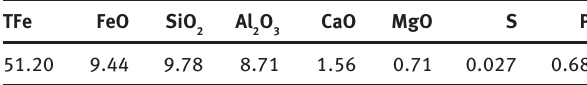
Table 1: Chemical analysis of raw materials (wt%).